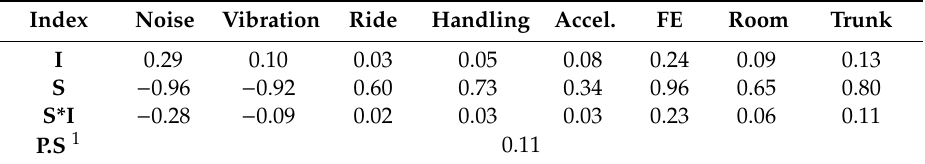
Figure 9. Market average satisfaction of each performance aspect. Table 2. Importance index (I), satisfaction (S), and SI of each performance aspect in the South Korean subcompact SUV market.